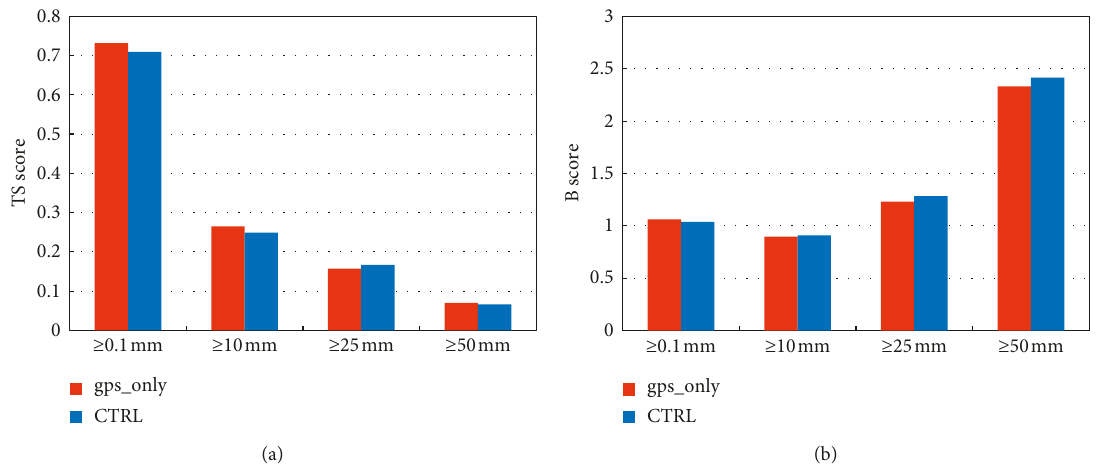
Figure 4: Comparison of the (a) TS score and (b) B score for 24-hour cumulative precipitation across several schemes from May 4, 2009, to August 30,